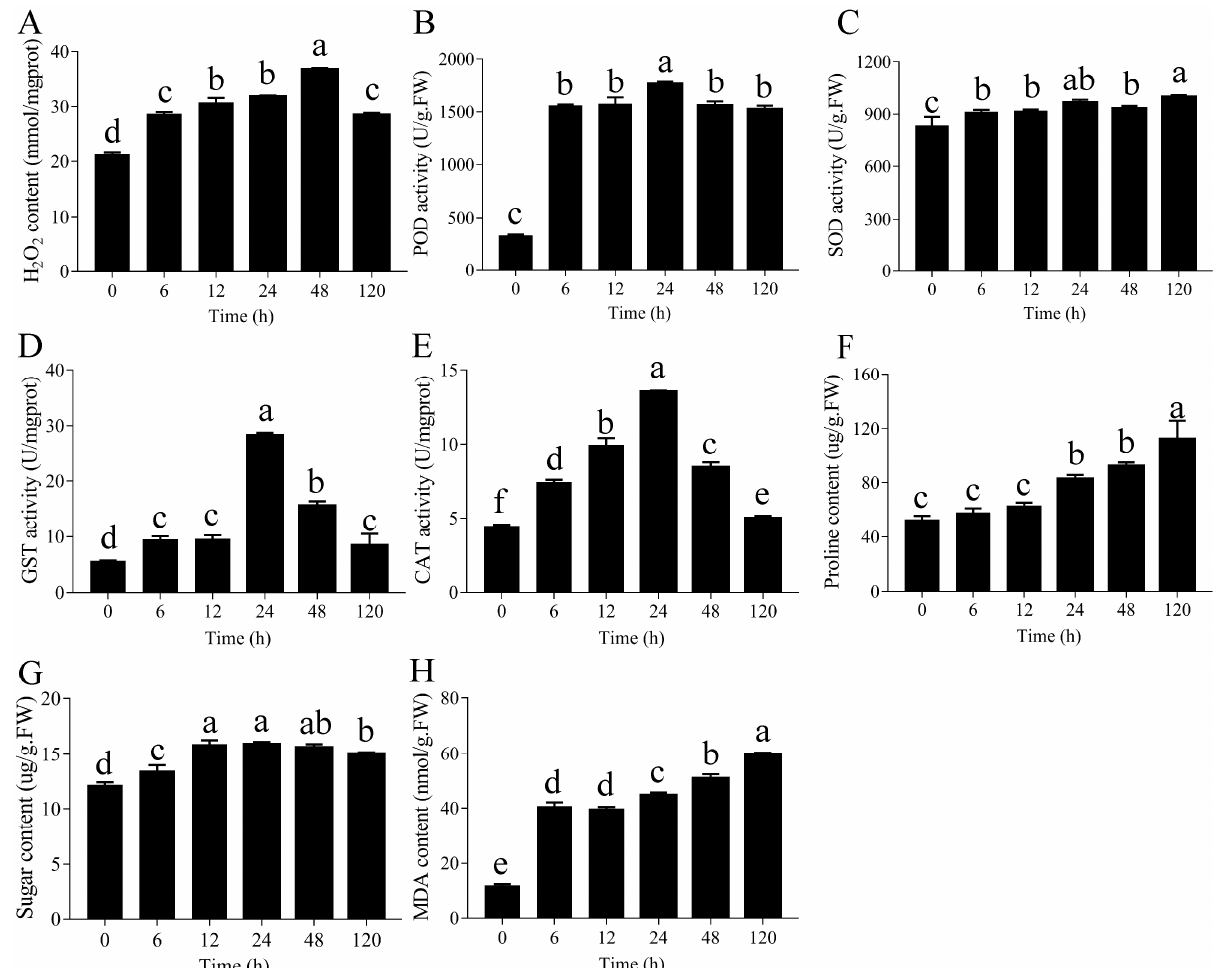
Figure 7. Effects of drought stress on the roots of Populus ussuriensis . ( A ) H 2 O 2 content, ( B ) peroxidase (POD) activity, ( C ) superoxide dismutase (SOD) activity, ( D ) glutathione S-transferase (GST) activity, ( E ) catalase (CAT) activity, ( F ) proline content, ( G ) total soluble sugar content, and ( H ) malondialdehyde (MDA) content. Different lowercase letters indicate statistically significant differences at p < 0.05. The values are shown as the mean of three biological replicates ± SE ( n = 3). After PEG-induced drought stress, the proline content levels in P. ussuriensis